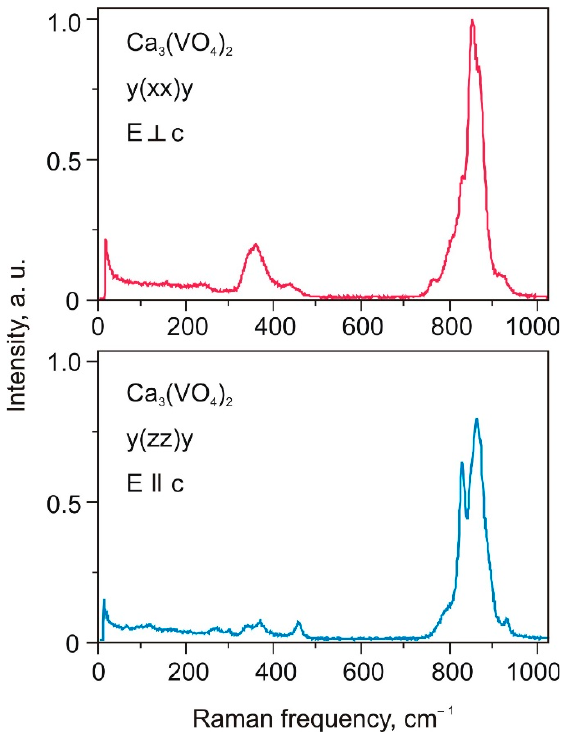
Figure 2. Polarized Raman spectra of Ca 3 (VO 4 ) 2 at room temperature.